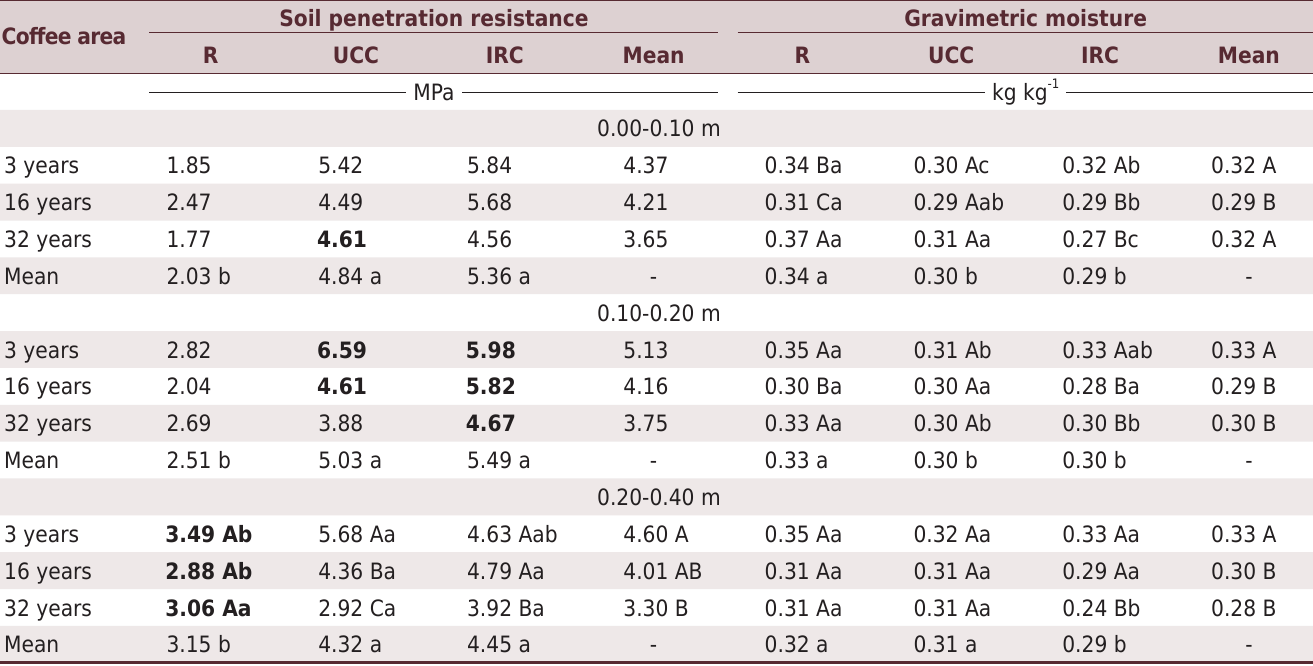
R: planting row; UCC: under the coffee canopy; IRC: inter-row center. Means followed by the same letter, lowercase in the row and uppercase in the column do not differ among themselves by Tukey test